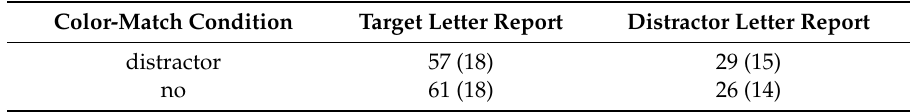
Table 2. Means and standard deviations (in brackets) in percent of reported target and distractor letters for the two color-match conditions of Experiment